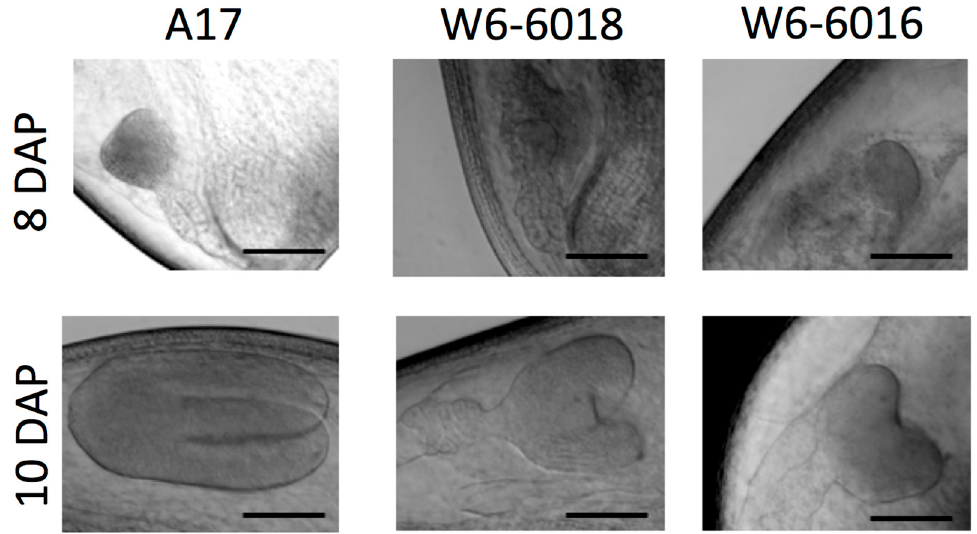
Figure 2. Embryo development of the different accessions. Differential interference contrast microscope (DIC) images of growing embryos from different accessions of Medicago (A17, left panel ; W6-6016, middle panel ; and W6-6018, right panel ) taken at 8 DAP ( upper panel ) and 10 DAP ( lower panel ). Scale bars = 0.5 mm.